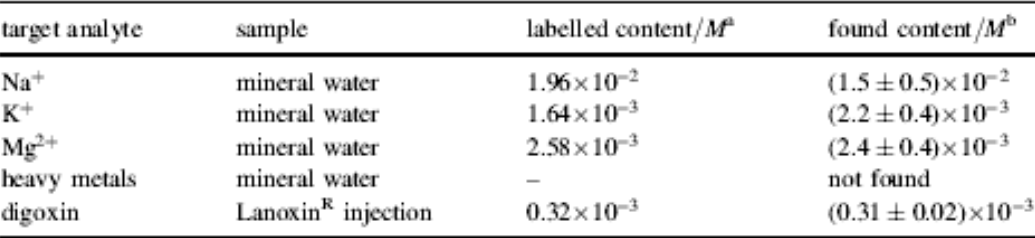
Table 4 . Application of ATPases assay to real samples. Reproduced from [102].